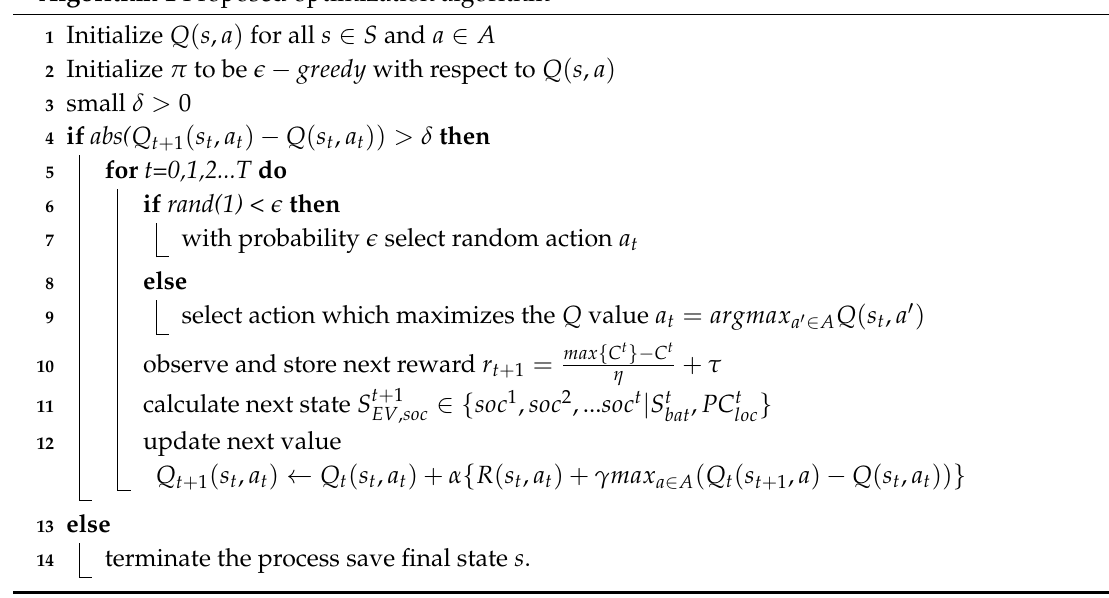
Figure 8. Multilayer Q-table for proposed optimization algorithm. Algorithm 1 Proposed optimization